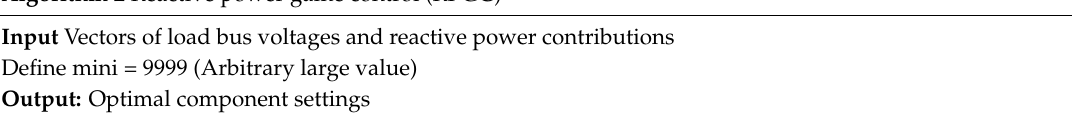
Algorithm 2 Reactive power game control